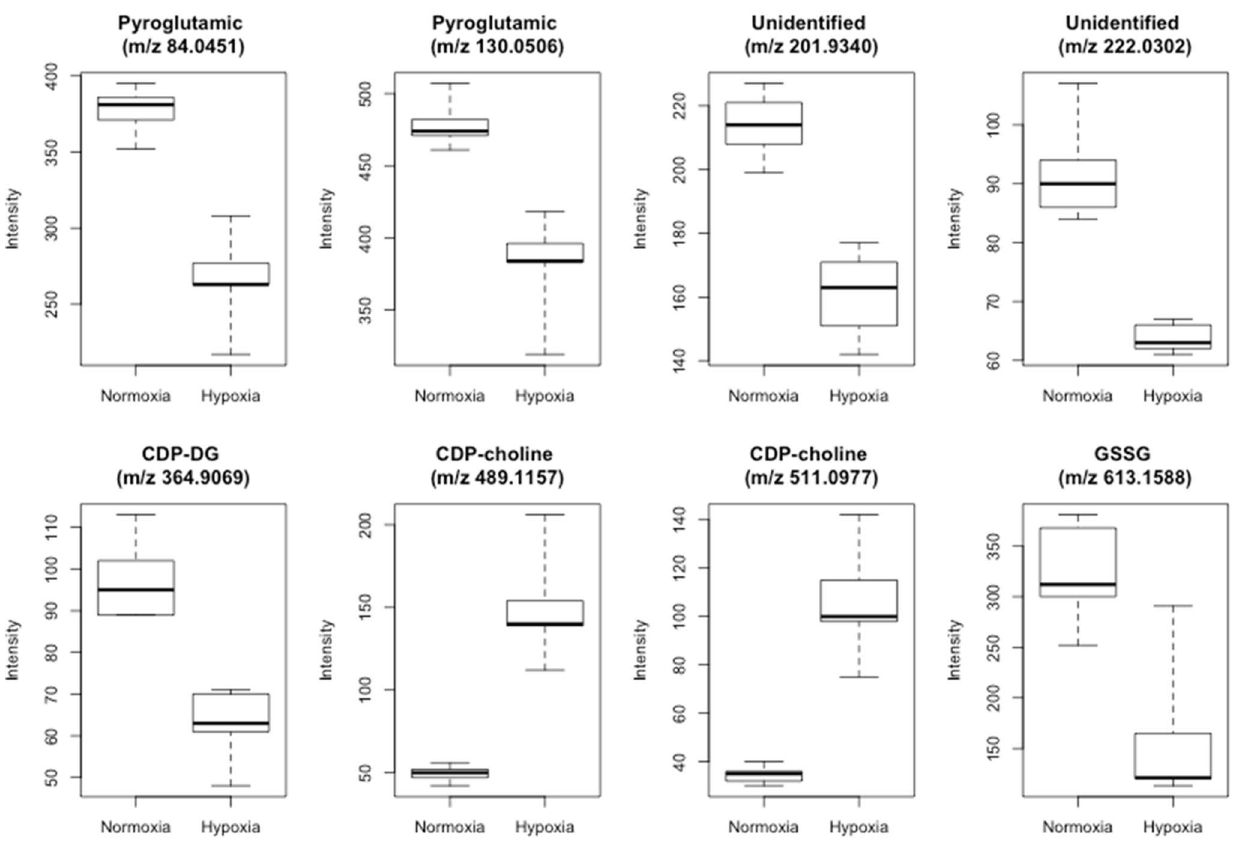
Figure 3. Intensities of the selected differentiating metabolites. Boxplots showing UPLC-QTOF intensities of the selected discriminant metabolites in retina of normoxic and severely hypoxic newborn piglets.